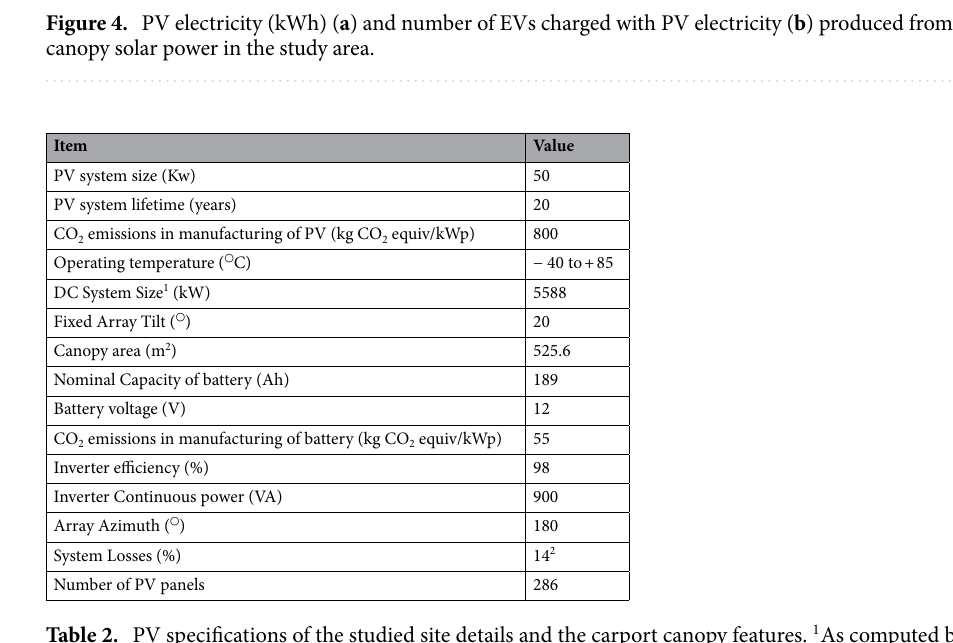
Table 2. PV specifications of the studied site details and the carport canopy features. 1 As computed by PVWatts after specifying the area. 2 System losses are calculated by taking into account numerous factors such as soil erosion, rainstorms, light-induced damage, cabling, shade, mismatch, aging, accessibility, dust, and so